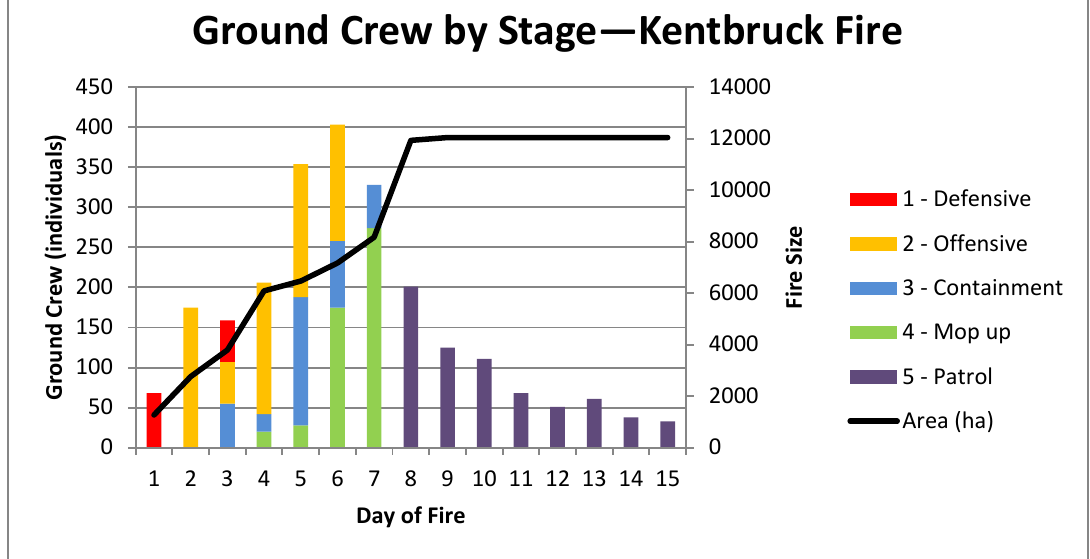
Figure 2. The left y axis is the number of ground crew (all fireline personnel except command staff, equipment operators and pilots), classified in sectors by stage, which is used as a proxy for fire resource use. Existing resource measures apply to a limited number of tasks occurring in stages 2 and 3 (a maximum of 45% of resource use).